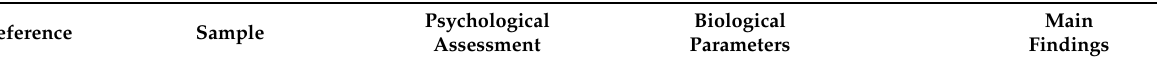
Table 4. Genetic